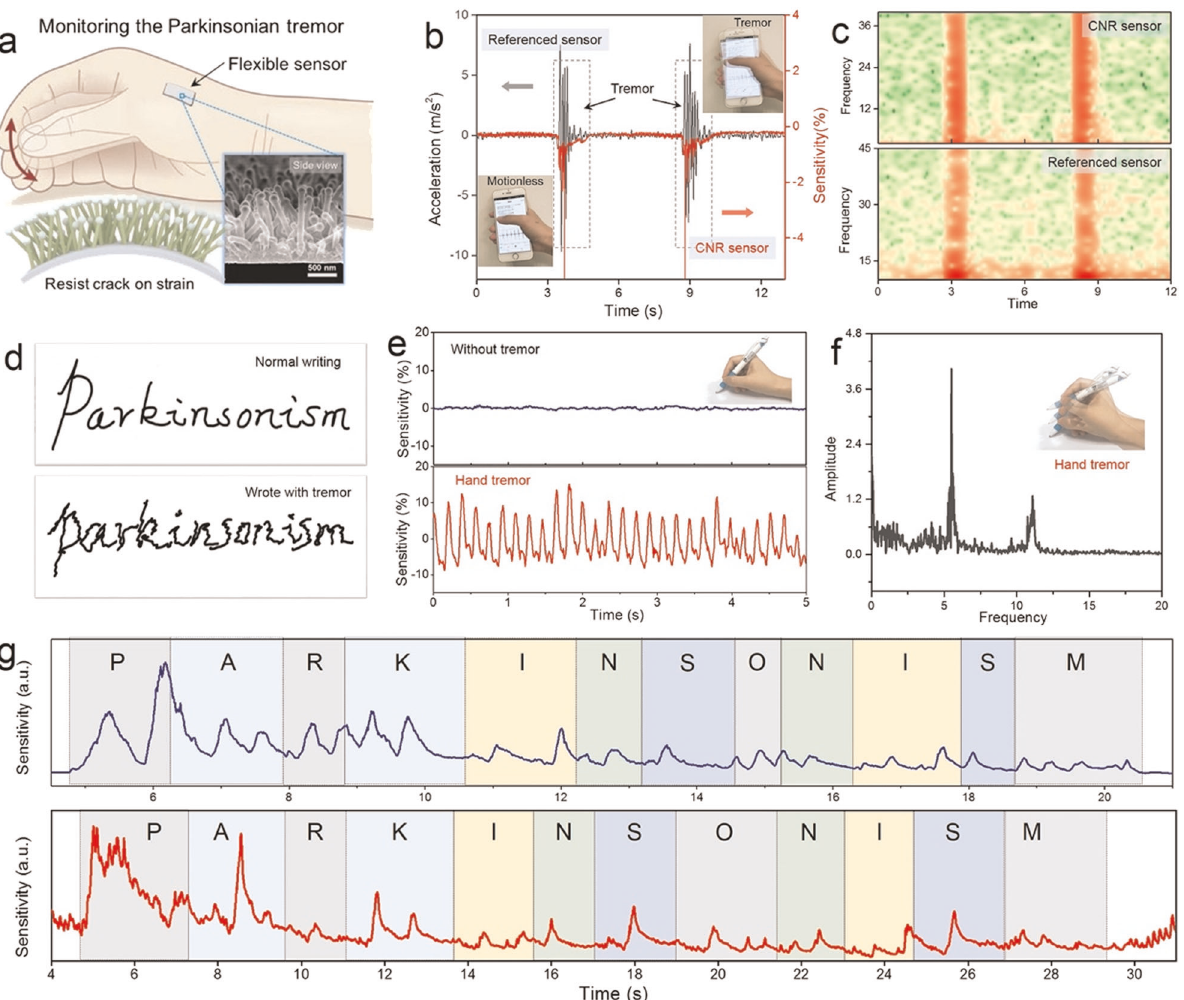
Fig. 5 Monitoring the Parkinsonian tremor by CNA-based fl exion sensors. a Schematic illustrations of monitoring Parkinsonian tremors by CNA-based fl exible sensor. b The CNA-based fl exible sensor and reference sensor of the iPhone 6 were placed on the human hand to monitor the simulated Parkinsonian tremors. Real-time response of CNA-based fl exible sensor (red curve) and reference sensor (black curve) recorded the hand tremors. c Short-time Fourier transform (STFT) processed signals of our fl exible sensor and referenced sensor, indicate that the performance of cost-effective CNA-based fl exible sensor is comparable with the reference commercial sensor. d Chirographies of normal writing and writing with tremor. e Real-time response of CNA-based fl exible sensors on monitoring the handwriting with and without tremors, suggests the sensor is sensitivity to hand tremors when writing. f Frequency spectrograms of fl exible sensor in detection of hand tremors, indicts that there are two frequencies vibrations of ~5.5 and ~11.0 Hz, respectively. g Real-time detection of handwriting on “ Parkinsonism ” with (red curve) and without (blue curve) simulated hands